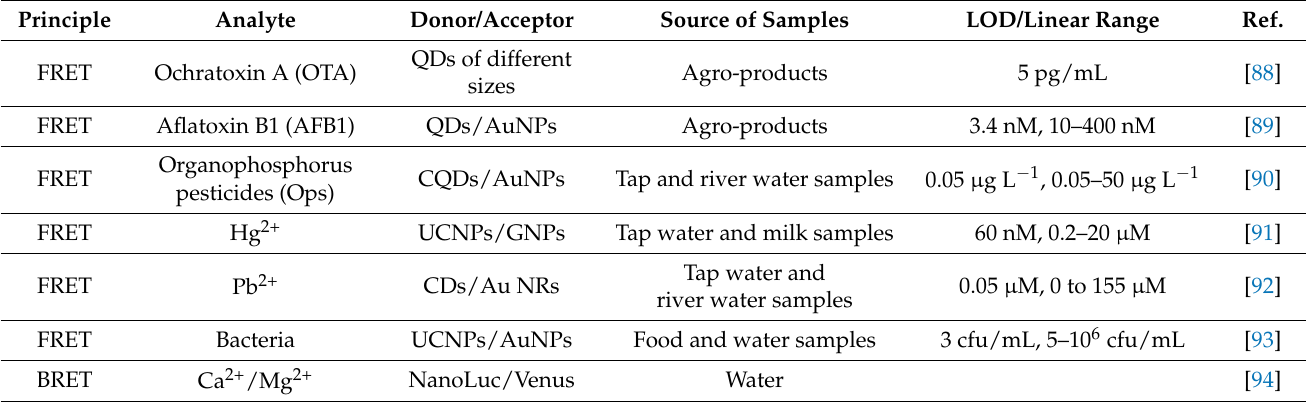
Table 3. FRET- and BRET-based biosensors for environmental